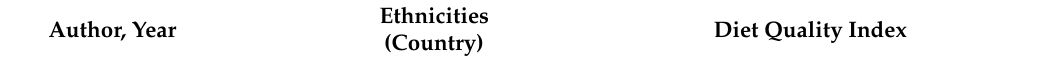
Table 3. Summary of diet quality scores among different ethnic